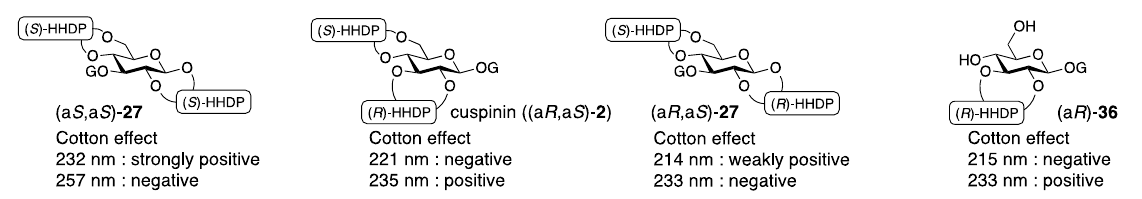
Figure 18. The comparison of the Cotton effects observed on (a S ,a S )- 27 , cuspinin ((a R ,a S )- 2 ), (a R ,a S )- 27 , and (a R )- 36 .